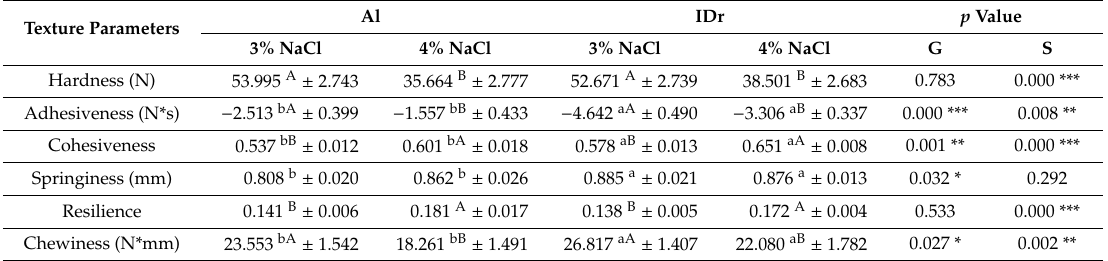
Table 4. Influence of pig genotype and salt content (% NaCl) in the texture profile analysis of Catal ã o . Texture